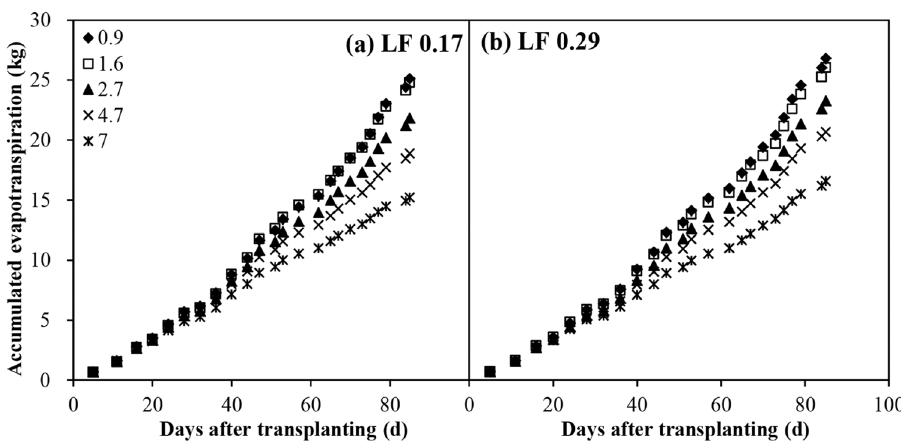
Figure 5. Evolution of cumulative evapotranspiration (ET) throughout the growth season under various irrigation water salinity levels and leaching fractions (LF).